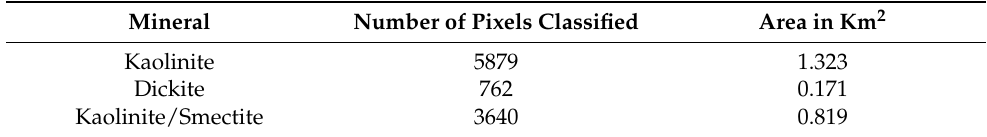
Table 2. Spatial distribution of the selected mineral according to the MTMF algorithm in volcanic